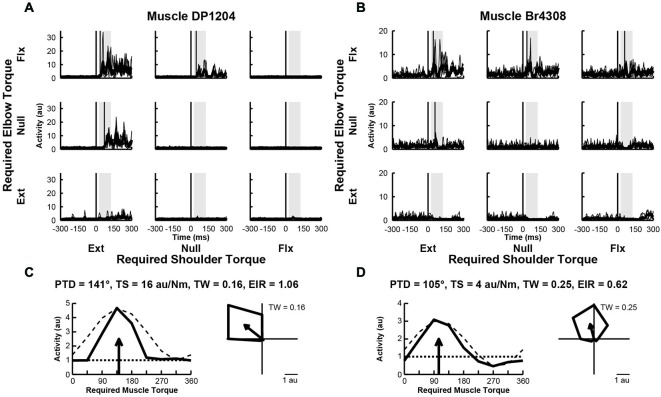
Activity of exemplar upper-limb muscles. (A) Electromyographic (EMG) activity of a posterior deltoid sample in each perturbation condition (arranged in joint-torque space). The posterior deltoid sample responded maximally to perturbations that required an extensor torque at the shoulder and a flexor torque at the elbow. (B) EMG Activity of a brachioradialis sample that responded maximally to perturbations that required a flexor torque at the elbow. (C,D) Directional tuning of the corresponding muscle samples. Left sub-panels illustrate linear plots of overall activity vs. joint-torque angle. Unloaded baseline activities and cosine fits are shown as dotted and dashed lines, respectively. Right sub-panels show polar plots of the perturbation-related activity (baseline removed) in joint-torque space. PTD, preferred-torque direction; TS, torque-slope; TW, tuning width; EIR, excitation-inhibition ratio.